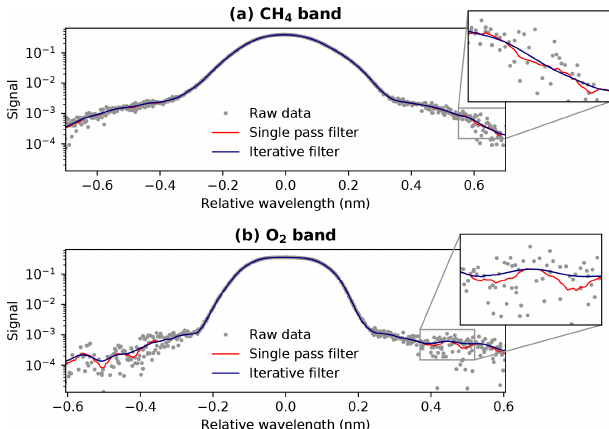
Figure 11. Demonstration of the iterative Savitzky–Golay filter used to smooth ISRF measurement data in the CH 4 (a) and O 2 (b) bands. One application of the filter, shown in red, was fairly effec- tive, especially for the CH 4 band. Successive iterations applied to the residuals at the tails provided additional smoothing while pre- serving the ISRF shape at the core, as indicated by the blue